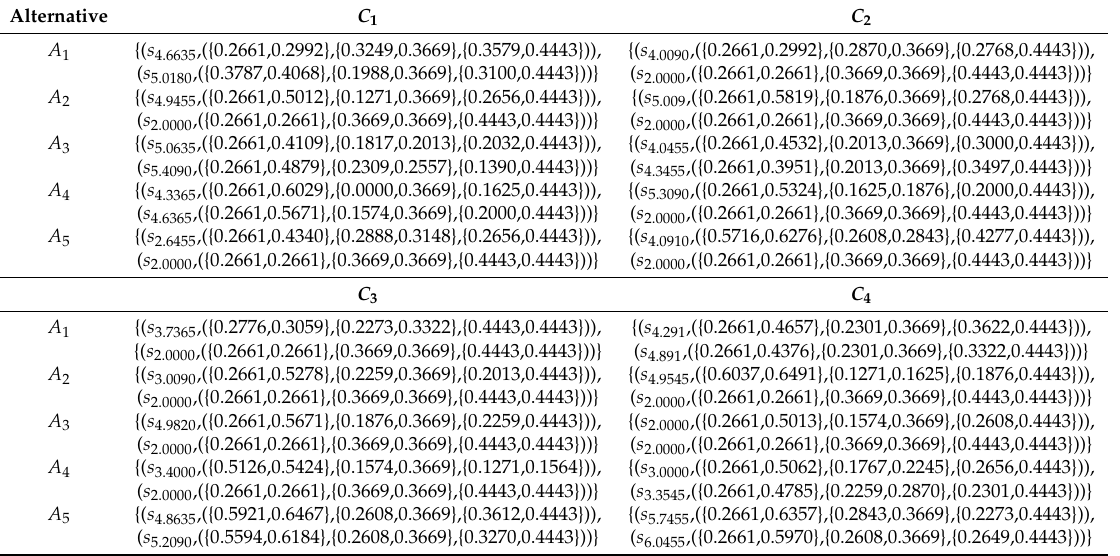
Table 5. Extended hesitant neutrosophic fuzzy linguistic decision matrix ˜ D